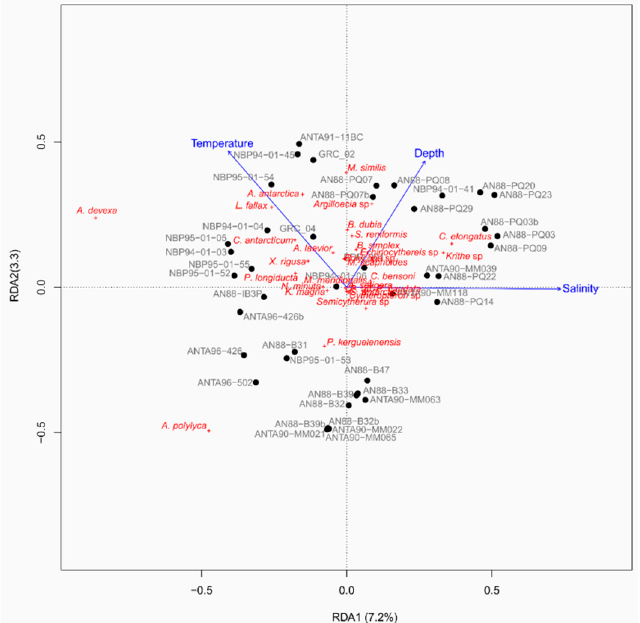
Figure 6. Redundancy analyses (RDA) showing the relationships between ostracod species and considered variables (salinity, temperature, depth).